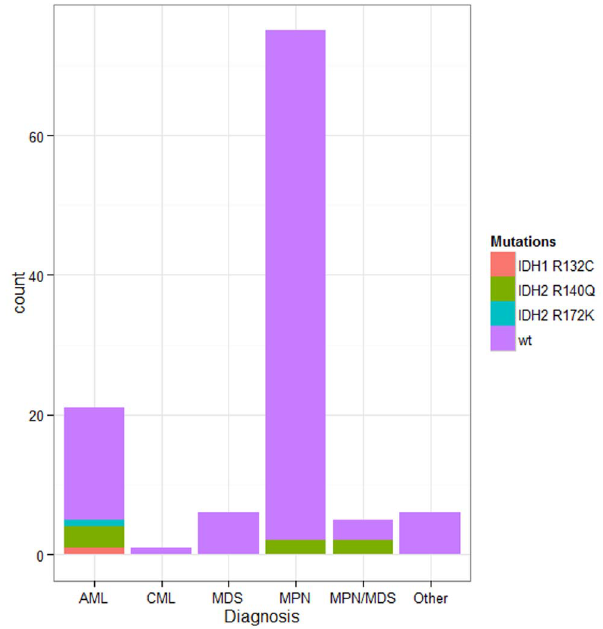
Figure 4. Distribution of mutated cases per disease entity.